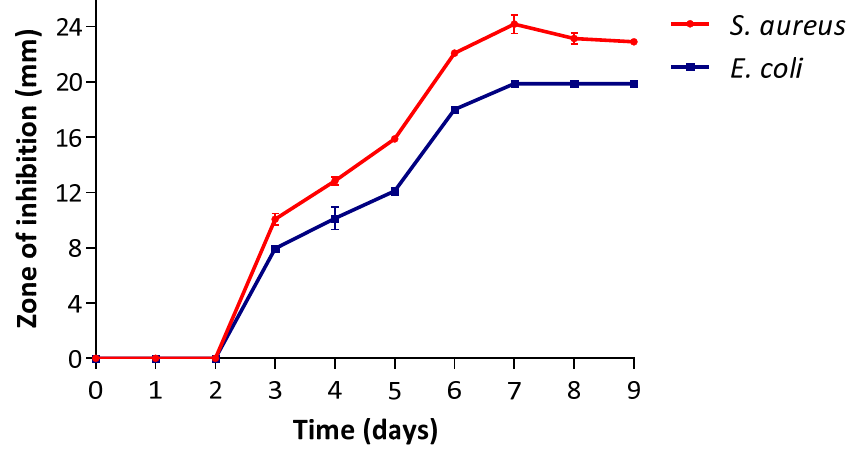
Figure 1. The zones of inhibition produced by the secondary metabolites as influenced by the elapsing time. Table 2. MIC and MBC values of the fungal